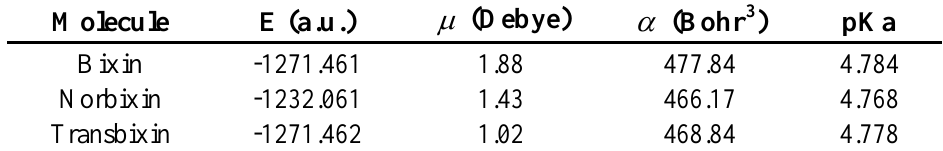
Table 5. Total energy E, dipole moment µ , polarizability α , calculated with the M05-